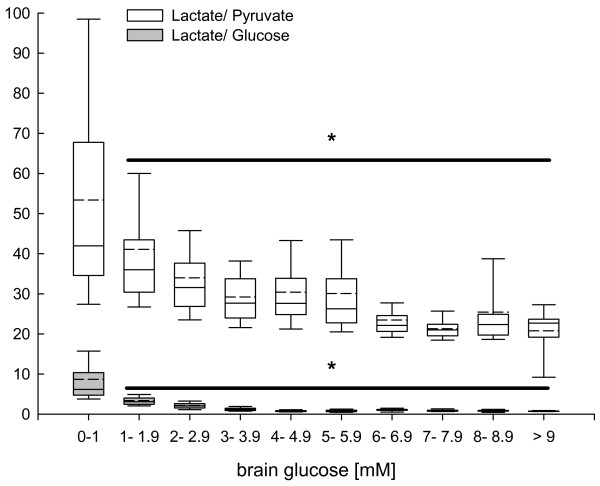
Changes in calculated brain lactate-to-pyruvate (grey box plots) and lactate-to-glucose (white box plots) ratio determined by microdialysis reflecting influence of brain glucose on downstream cerebral metabolism in pre-defined brain glucose clusters, ranging from less than 1 mM to more than 9 mM in 1 mM buckets. At brain glucose levels exceeding 1 mM brain lactate-to-pyruvate and lactate-to-glucose were significantly decreased. Changes across the pre-defined brain glucose clusters compared with low brain glucose levels (<1 mM) were significant (*P < 0.001; analysis of variance on ranks, post hoc Dunn's test).